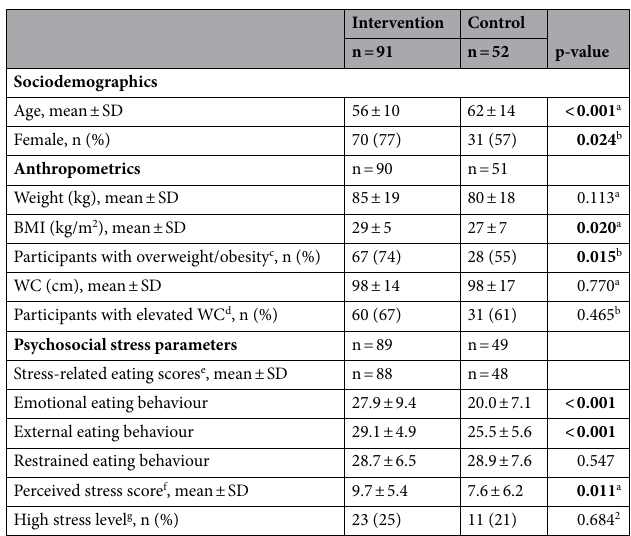
Table 1. Baseline characteristics by study group (n = 143). Significant values are in bold. BMI Body Mass Index, WC Waist circumference, a Mann–Whitney- U test, b Fisher’s exact test, c BMI ≥ 25 kg/m 2 , d ≥ 102 cm and ≥ 88 cm for men and women, respectively, e Dutch Eating Behavior Questionnaire 13 . f Perceived Stress Scale (PSS)-10 score 49 , g PSS-10 score ≥ 14.